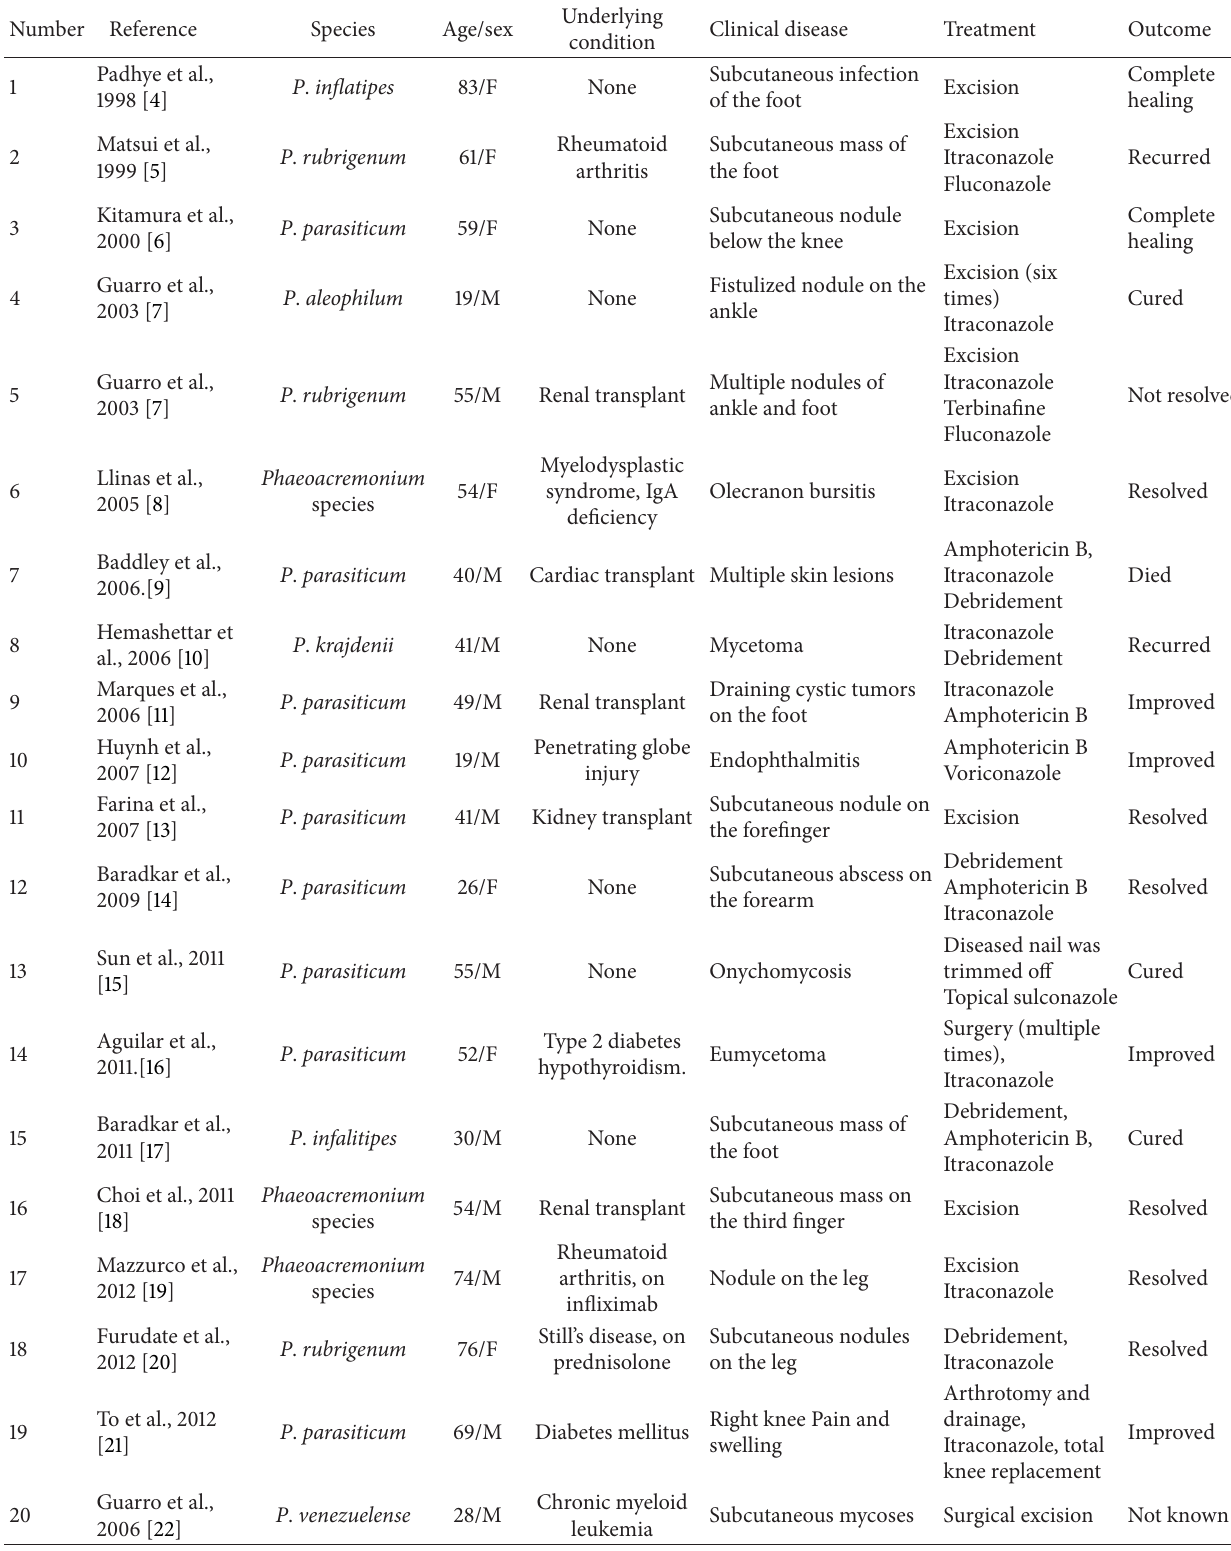
Table 1: Skin and subcutaneous infection, osteomyelitis, endophthalmitis, and onychomycosis due to Phaeoacremonium